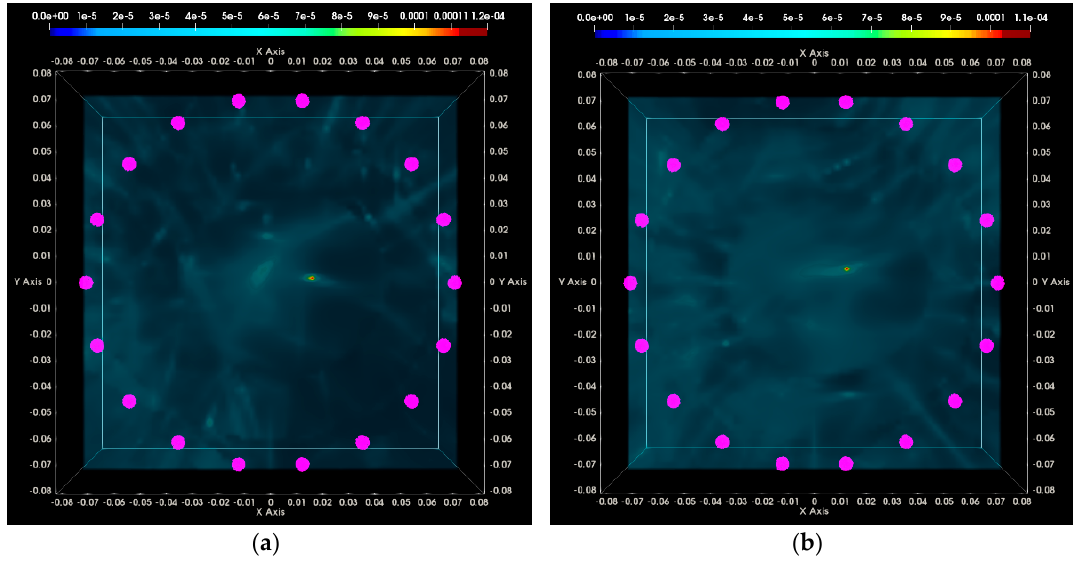
Figure 16. Breast rotational position #1—image formed at a single vertical position of the sensor network, in front of the tumor; top XY view of the full imaging domain (the antennae center positions are depicted with purple dots): ( a ) Test Date 1; ( b ) Test Date 2.